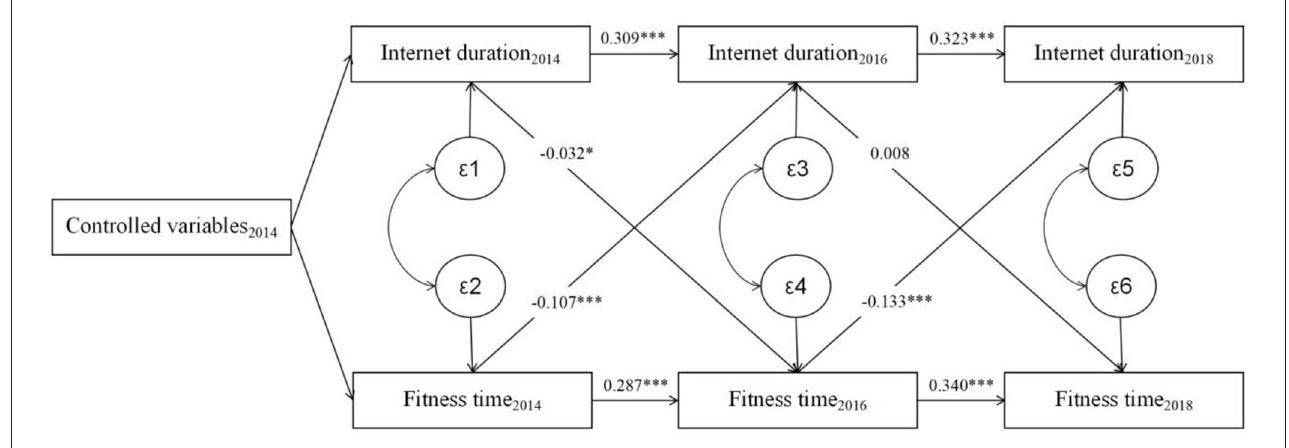
FIGURE2 The estimation of the cross lagged panel model of the internet duration and physical fitness time.